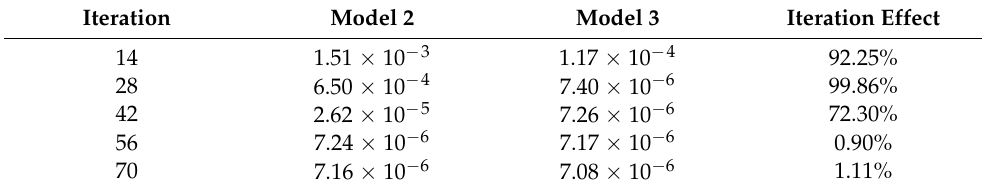
Table 2. MSEs at different